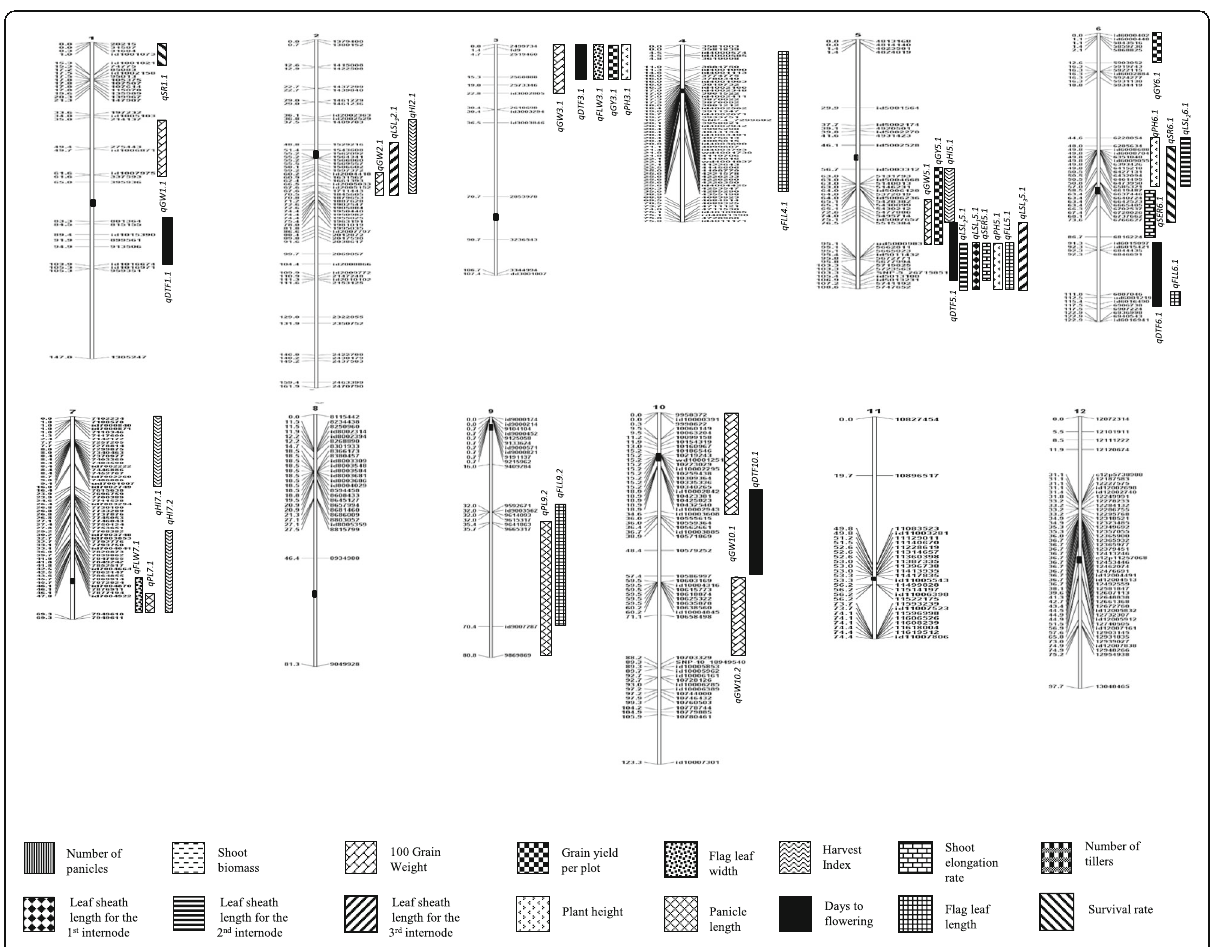
Fig. 1 Linkage map of a RIL population (F 7 ) derived from a cross between Ciherang-Sub1 and IR10F365 under stagnant flooding along with the positions of QTLs for 16 traits. QTLs identified are indicated above each bar, traits are indicated by the patterns of the bars. Centromeres are shown as black boxes in each